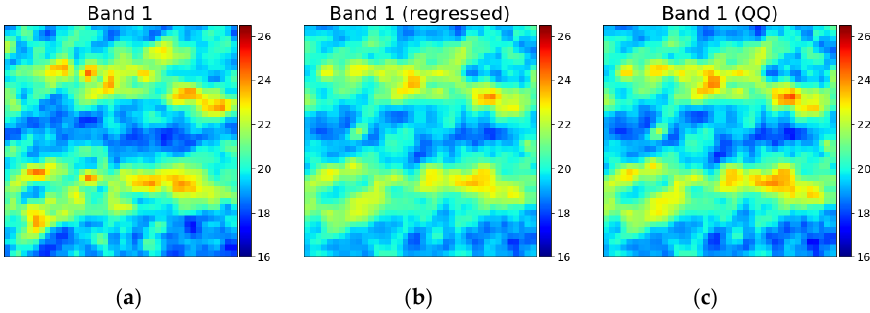
Figure 9. Water reflectance of Band 1 for the subset area in Scene-A: ( a ) original data, ( b ) scaled from Band 2 through the location-based regression, and ( c ) scaled from Band 2 with the QQ-based regression.